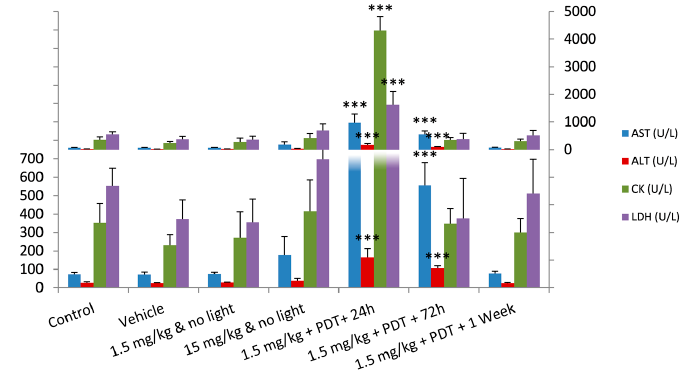
Figure 1. Summary of the most relevant results from serum biochemistry of Wistar rats, presented as average ± SD. (*** difference relative to the control group— p < 0.001). The two panels present the same results in different scales to highlight the inter-group differences.